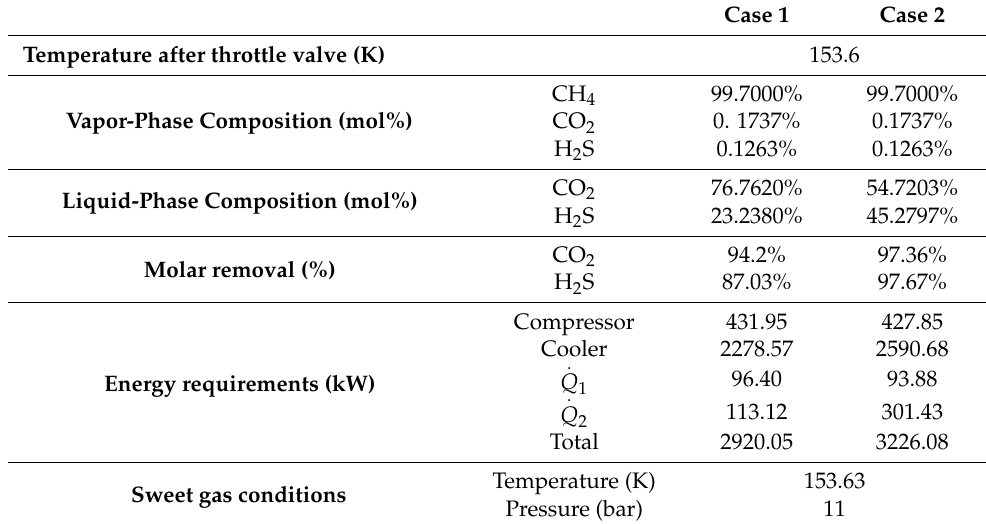
Table 4. Optimized results of the SV separation